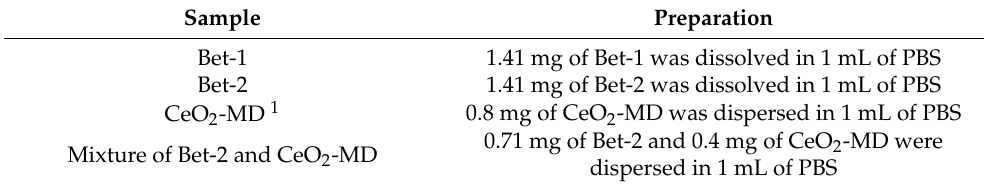
Table 6. Composition of the samples to measure the biological